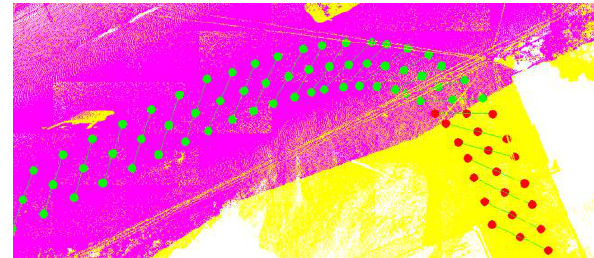
Figure 13. Point’s triplet along trajectory